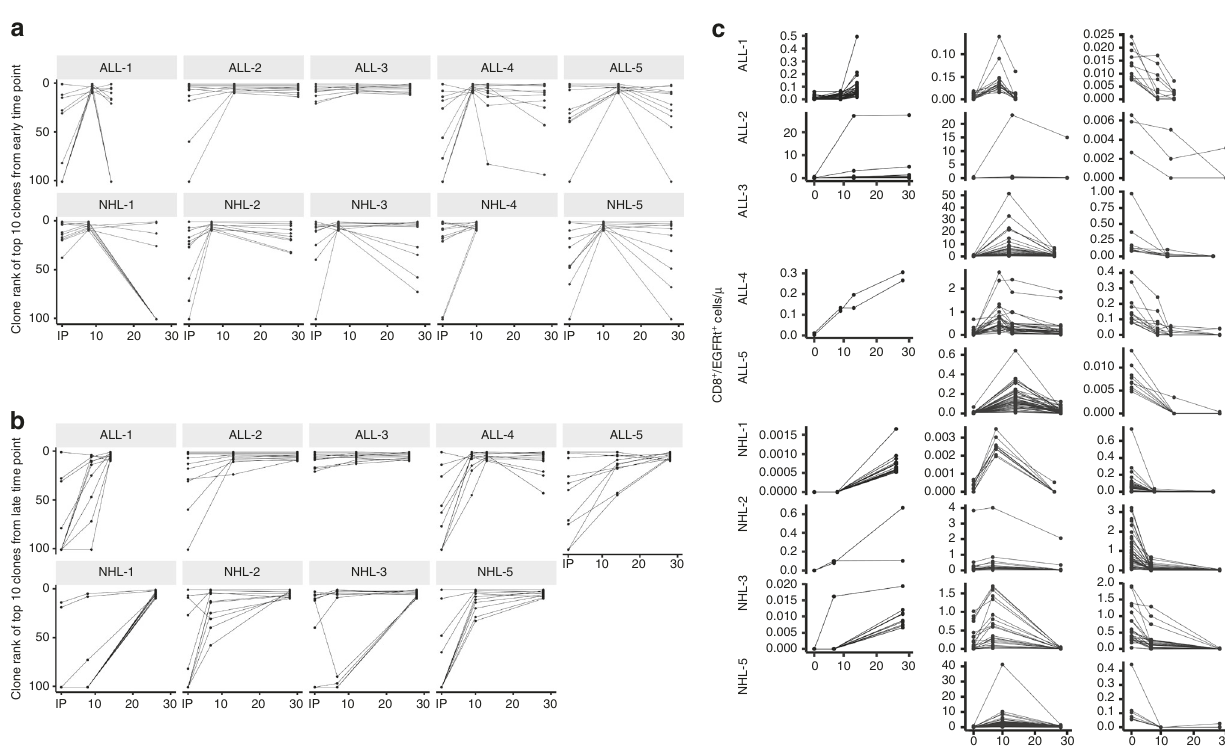
Fig. 3 Distinct CD8 + CAR-T cell clones exhibit different kinetic behaviors after infusion. a The rank of the top ten CD8 + CAR-T cell clonotypes from the early time point are shown in the IP and at different time points after infusion. b The rank of the top ten CD8 + CAR-T cell clonotypes from the late time point are shown in the IP and at different time points after infusion. All rank positions >100 were designated in the fi gure as having a rank position of 101. Each line represents an individual clonotype. c The absolute counts of the top 30 CD8 + CAR-T cell clones from the IP, early, and late time points were tracked over time. The absolute count at Day 0 represents the absolute count of CD8 + CAR-T cells distributed in blood immediately after infusion, calculated based on the infusion dose. Left, clones whose absolute cell numbers increased in blood after infusion. Middle, clones whose absolute numbers increased in blood early after infusion then decreased. Right, clones whose absolute cell numbers decreased in blood after infusion. There were no increasing clones for ALL-3, ALL-5, and NHL-5. Each line represents an individual clone. Source data are provided as a Source Data fi